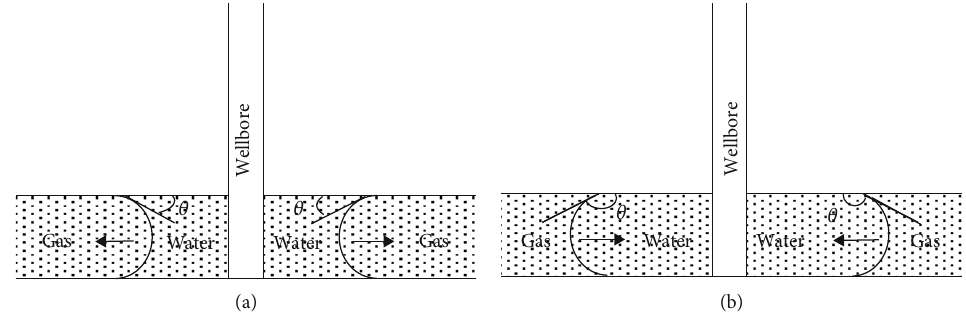
Figure 4: The coal capillary force directions: (a) hydrophilic surface of coal and (b) nonhydrophilic surface of